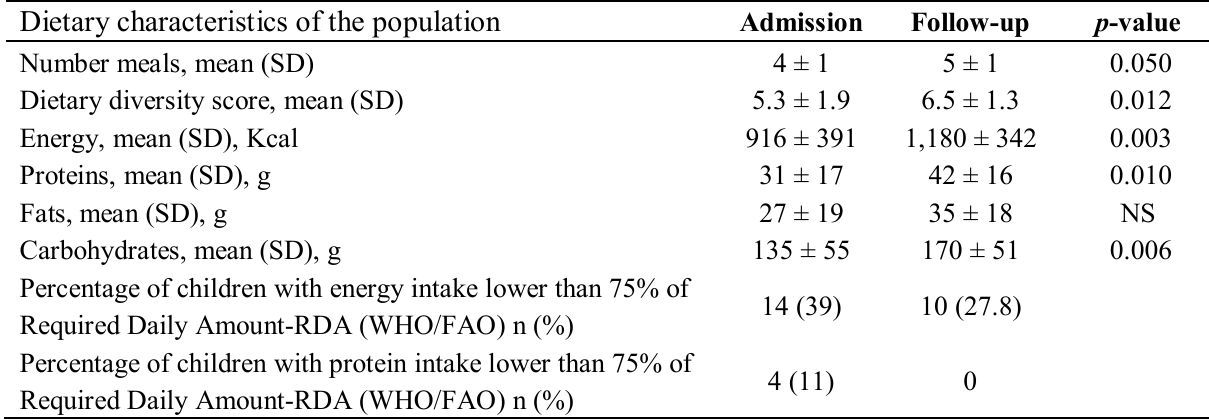
Table 4. Dietary characteristics of the